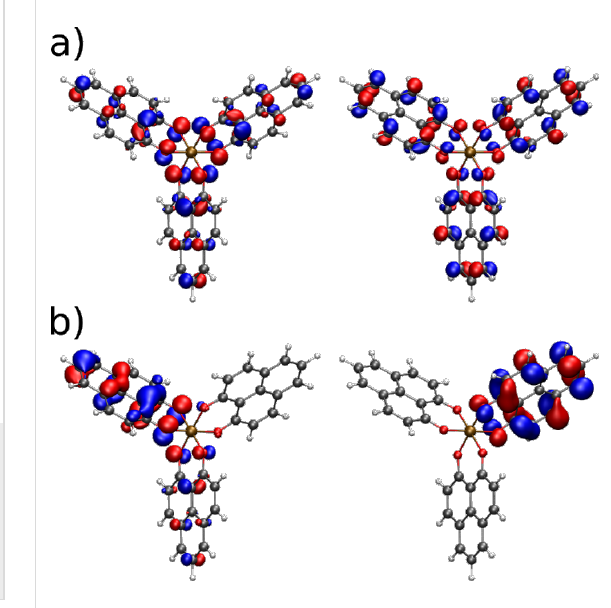
Figure 7: a) HOMO (left) and LUMO (right) orbitals of Al(Op) 3 calcu- lated with TURBOMOLE [36] on a B3-LYP [37]/SV(P) [38] level of theory in vacuum. b) The same orbitals calculated in the explicit matrix, represented by a self-consistently evaluated cloud of point